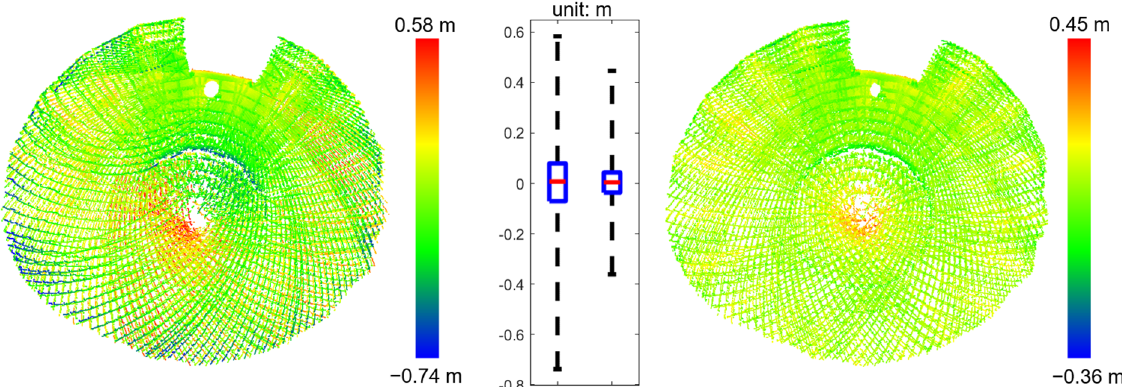
Figure 31. Heat maps and box plots representing the normal distance between the roof feature points and fitted quadratic surface for the Lebanon dataset before (left) and after (right) partial fine registration.